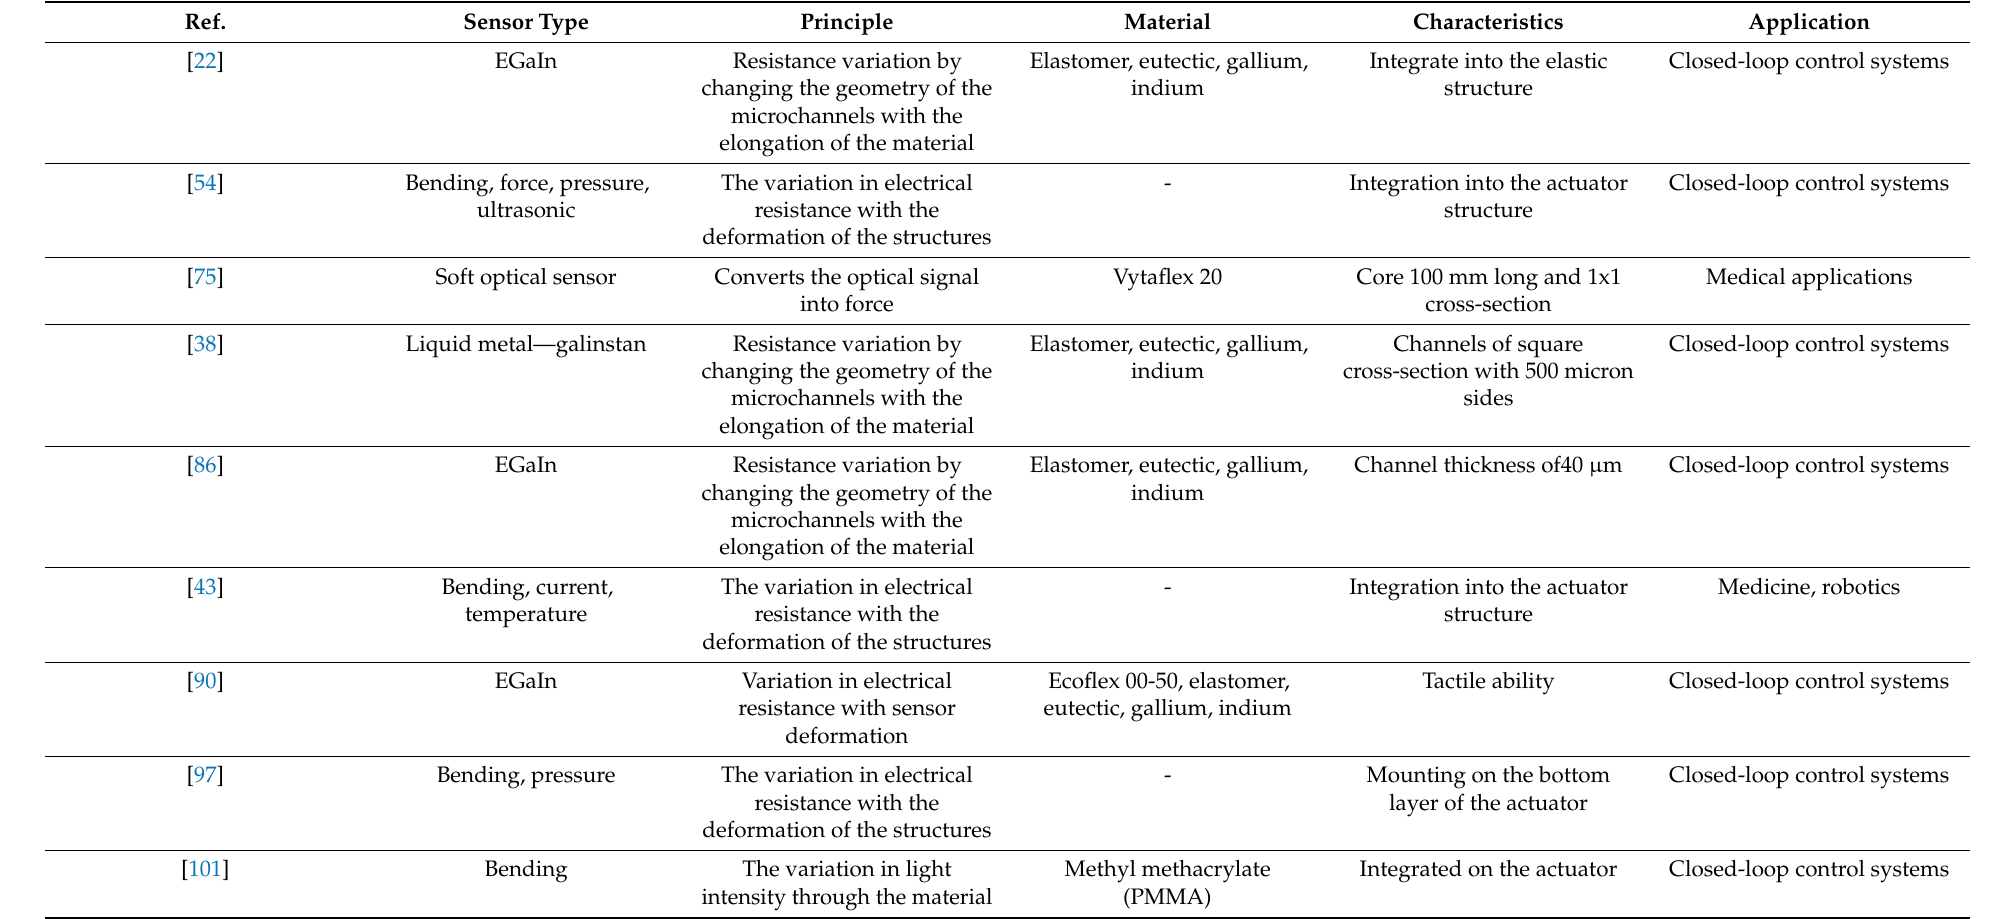
Table A6. Analysis of bibliographic references according to the sensors.